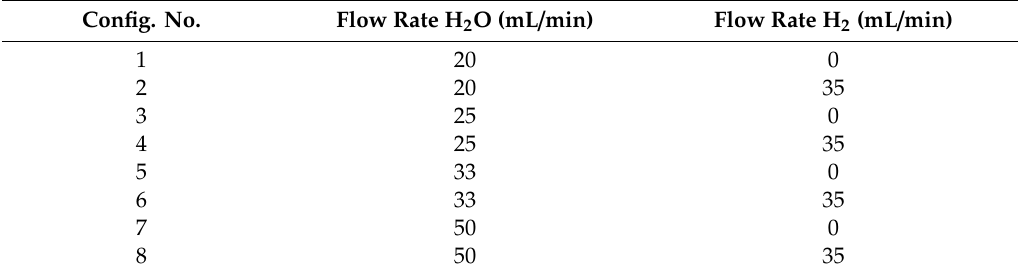
Table 3. Experiment configurations for steam gasification; N 2 was added to yield a total gas flow of 100 mL / min.